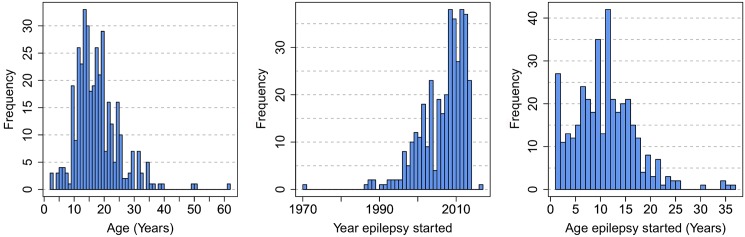
From left to right: the age distribution of epileptics in Titule, the year their epilepsy started, and their age upon first epilepsy seizure.